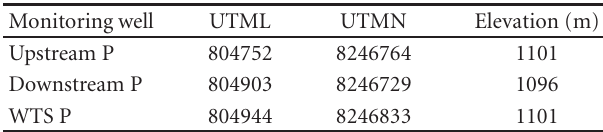
Table 1: Monitoring wells located upstream (Upstream P), down- stream (Downstream P), and in the area of disposal of WTS (WTS P). Datum: Astro